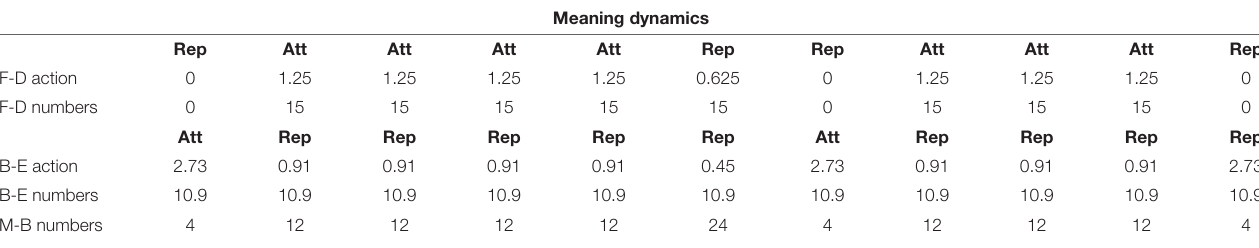
TABLE 4 | The “meaning dynamics” belonging to the example of “four sentences distributed over seven energy levels with total energy equal to seven”. Meaning